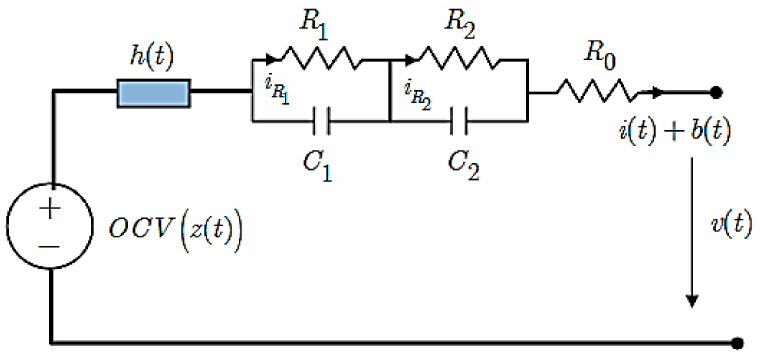
Figure 2. The second order equivalent circuit model of a lithium-ion